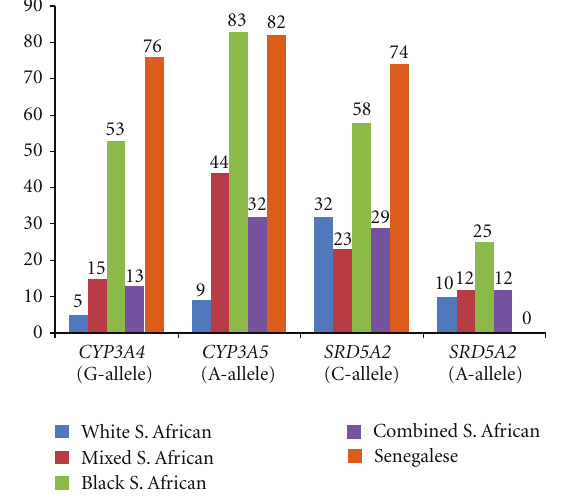
Figure 1: Minor allele frequencies among South African and Senegalese